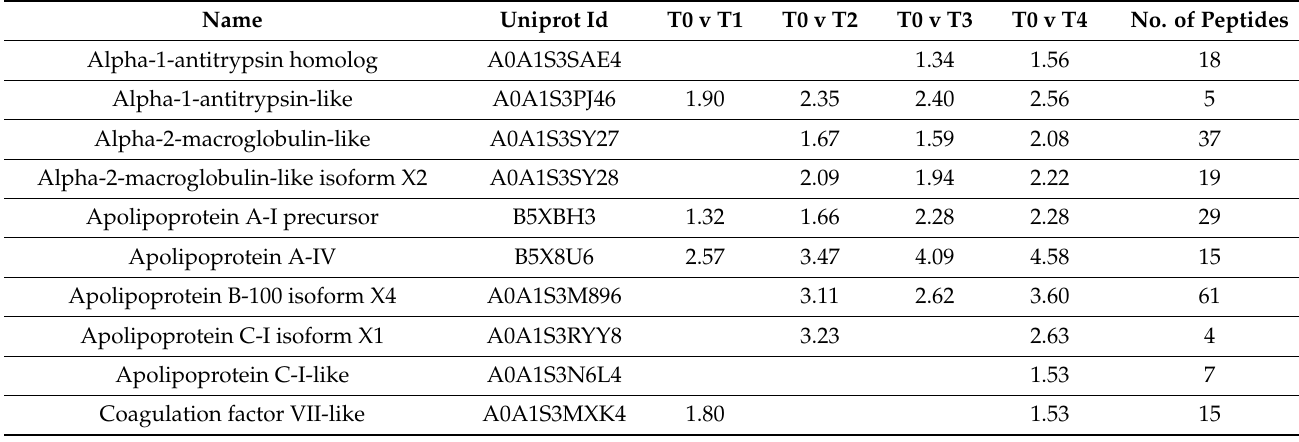
Figure 3. Heatmap plot of the proteins exhibiting t-test differences of at least +/- 1.5 in ( A ) control (T0) and post freshwater treatment samples (T1), ( B ) control (T0) and 7 days post re-infection samples (T2), ( C ) control (T0) and 14 days post re-infection samples (T3) and ( D ) control (T0) and 18 days post re-infection samples (T4) after LFQ values were z-score normalized. Hierarchical clustering was performed using Euclidian distance and average linkage using the Perseus software. Table 1. Immune-related proteins differentially expressed in the gills of P. perurans inoculated salmon after freshwater treatment for initial P. perurans infection (T1) and at three timepoints post re-infection (T2, T3, and T4). Proteins were identified by mass spectrometry and analysis was performed by Max Quant and Perseus computational platforms. For each time point protein expressions were compared to naïve controls (T0). Reported fold change values were obtained by calculating the difference between the mean log 2 transformed values for the two compared conditions ( p value <